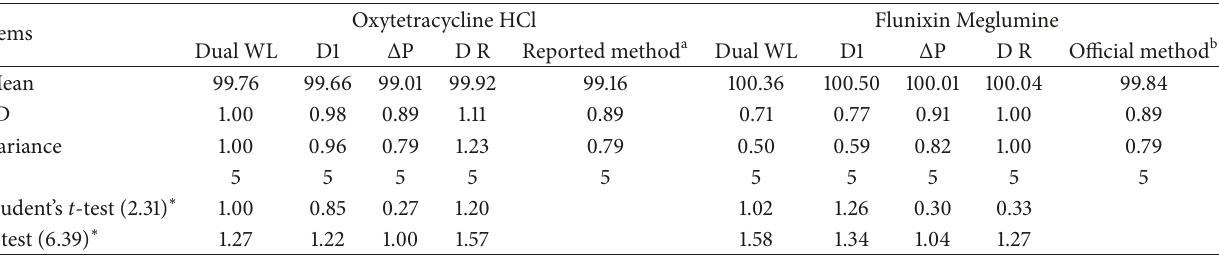
Table 5: Statistical comparison of the results obtained by the proposed spectrophotometric methods and the reported method for the